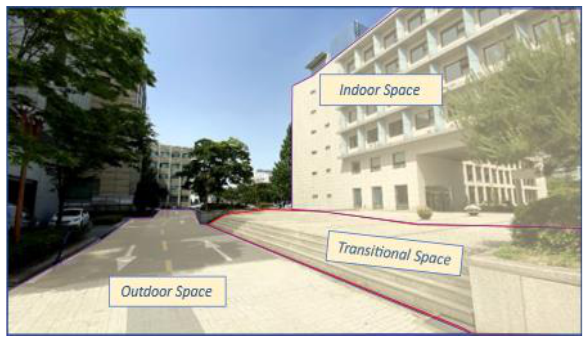
Figure 2 . Transitional space between Indoors and